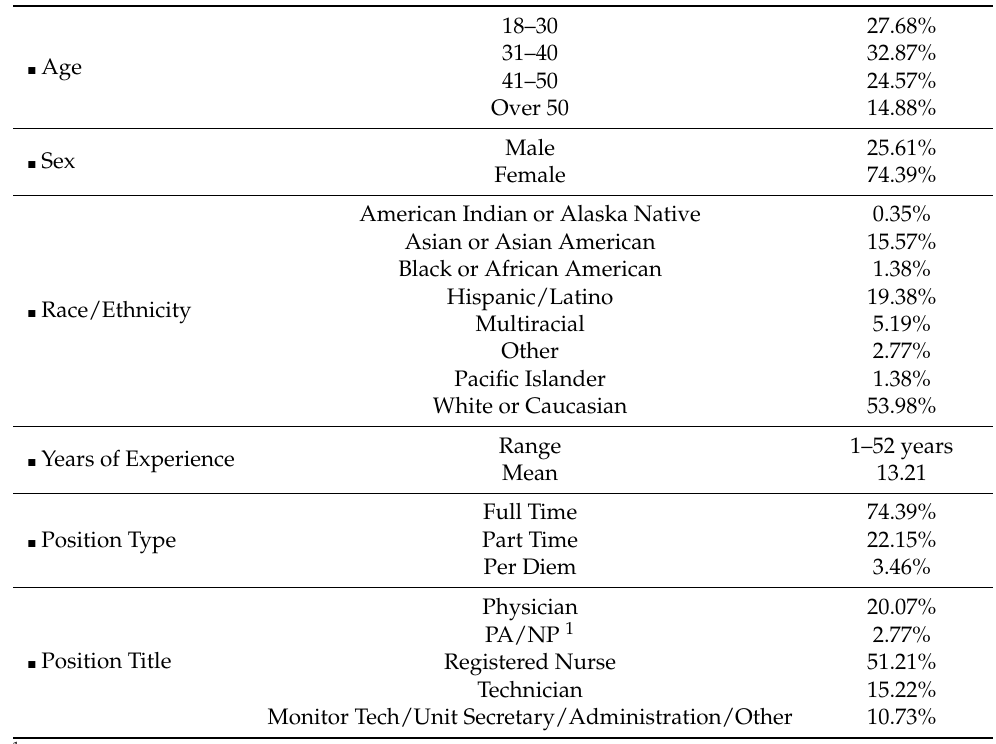
Table 1. Descriptive Statistics ( N = 289).